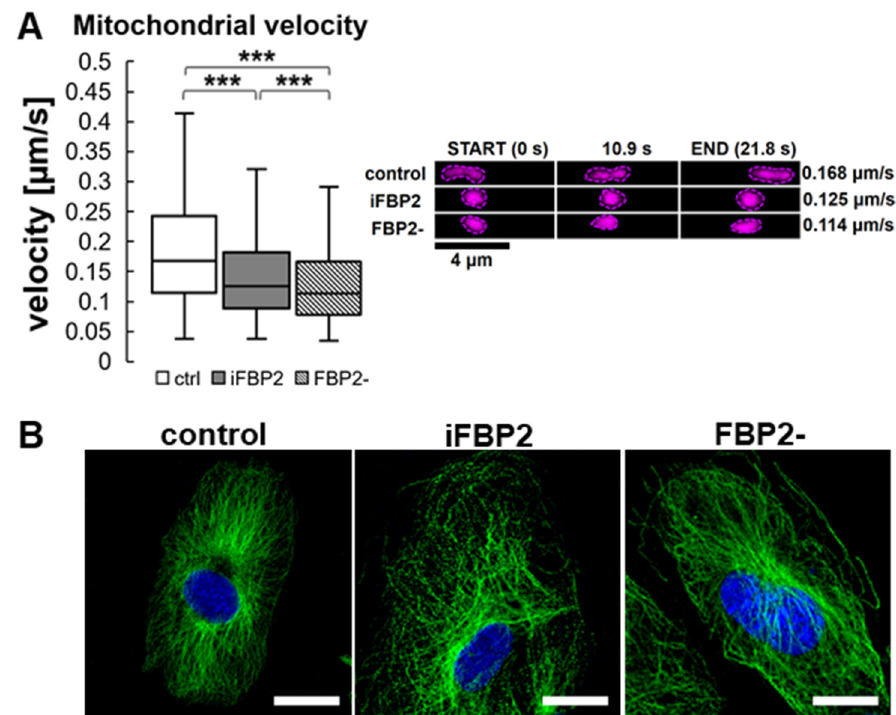
Figure 3. Mitochondrial velocity and microtubule cytoskeleton (MT) architecture in HL-1 cells. Quantification of mitochondrial velocity and graphical presentation of the velocity in a time range ( A ) and representative microscopic images of MT cytoskeleton ( B ) in different conditions. Ctrl—untreated HL-1 WT cells, iFBP2—FBP2 tetramerizing agent-treated cells; FBP2-—cells with partially silenced expression of FBP2. Data are presented as median and interquartile range. *** p < 0.001. Bar = 20 µm.